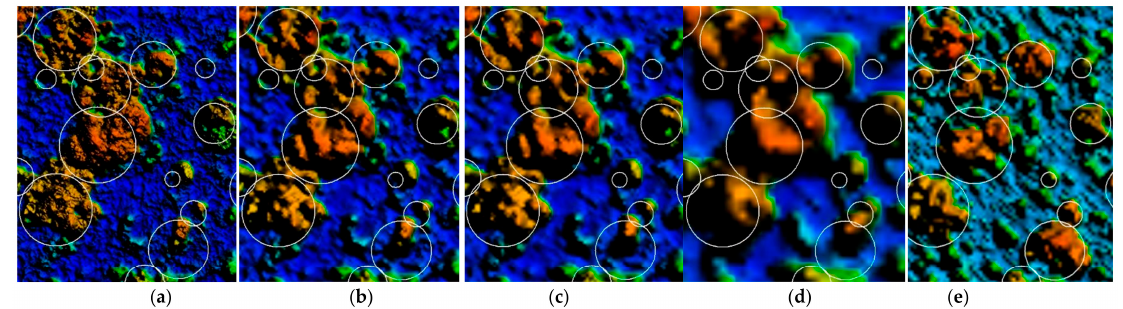
Figure 5. Study area subset (35 × 42 m) of Photomod processed raster canopy height models (CHMs) with different ground sample distance (GSD) resolutions, and applied a 3 × 3 smoothing kernel filter. ( a ) Original 10-cm GSD; ( b ) 30 cm; ( c ) 40 cm; ( d ) 1 m and ( e ) LiDAR 50-cm CHM. White circles represent the crowns of reference trees (height > 10 m).